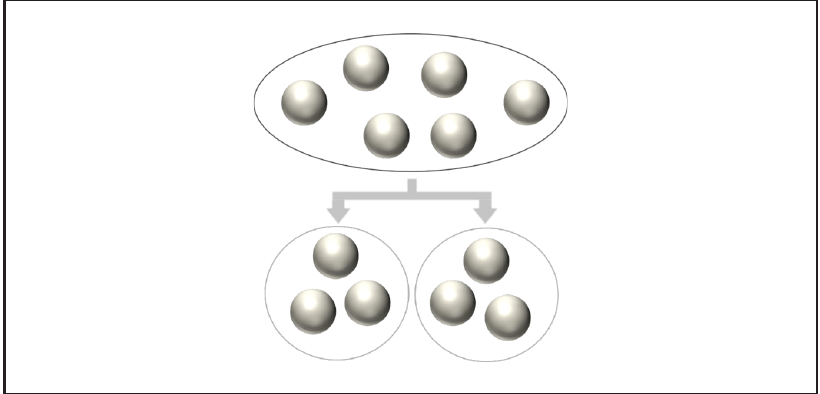
Figure 2: The concept of addition (and equally of